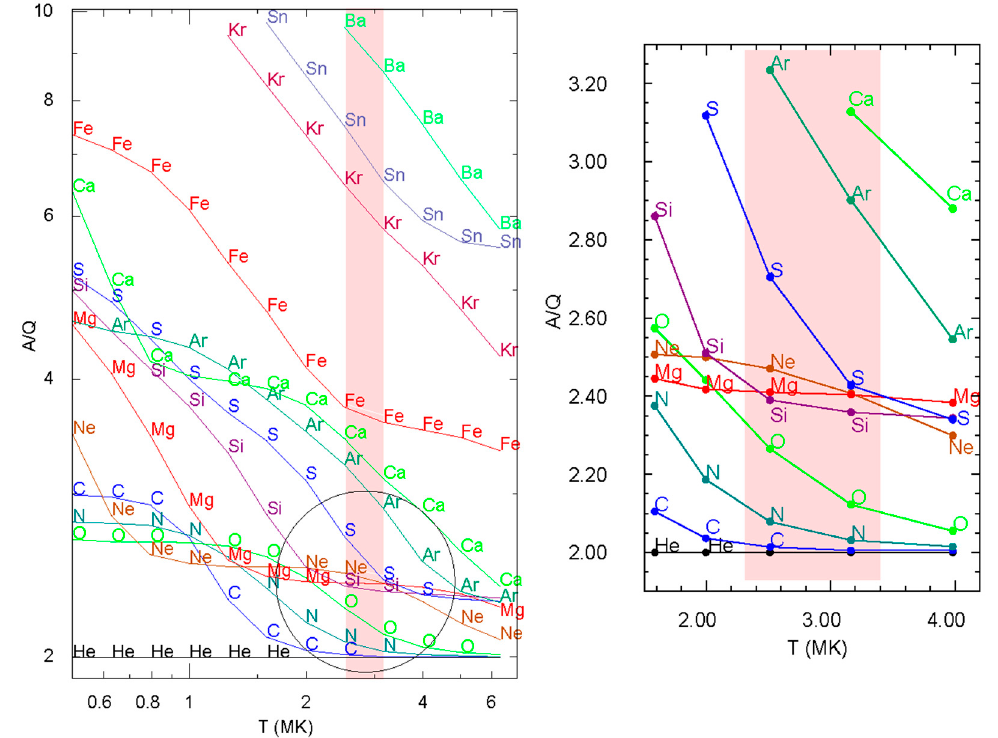
Figure 4. The dependence of A/Q on T for selected elements as indicated. Values from He through Fe are from Mazzotta et al. [72]; those for higher Z are from Post et al. [73]. The region circled in the left panel is magnified in the right panel especially to show the ordering of Ne, Mg, Si, and S in the 2.5–3.2 MK region. As measurements improved, the ordering of abundance enhancements was found to follow the ordering of A/Q at this source T [67,68].